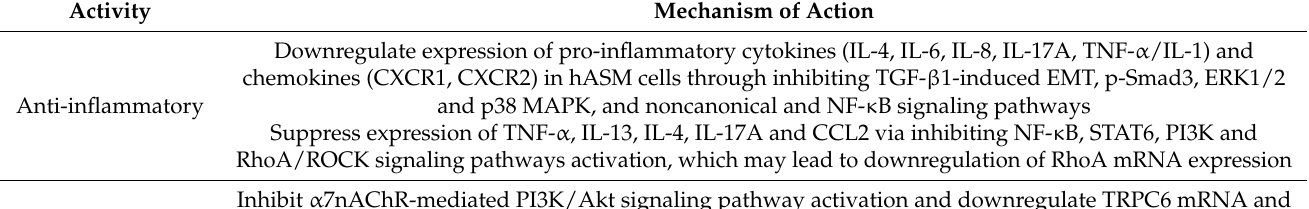
Table 3. Therapeutic potential of flavone compounds from S. baicalensis in nicotine-induced asthma. Activity Mechanism of Action